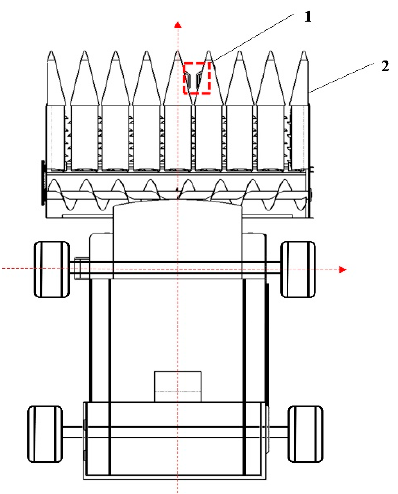
Table 1. The main parameters of the touch-to-travel mechanism.